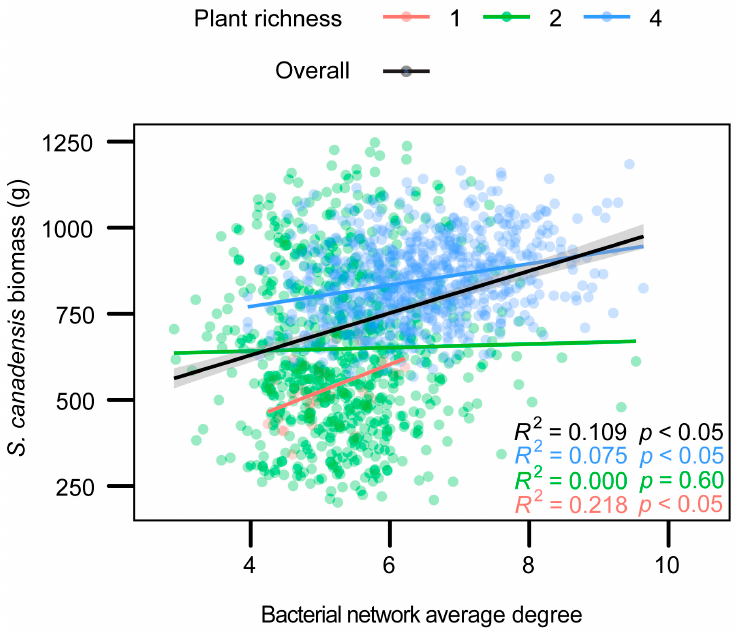
Figure 3. The relationship between invader biomass and bacterial network complexity. Points and lines represent different native species richness levels in red, green, and blue. The black line shows the overall trend of all data points, with shaded areas in the 95% confidence intervals.